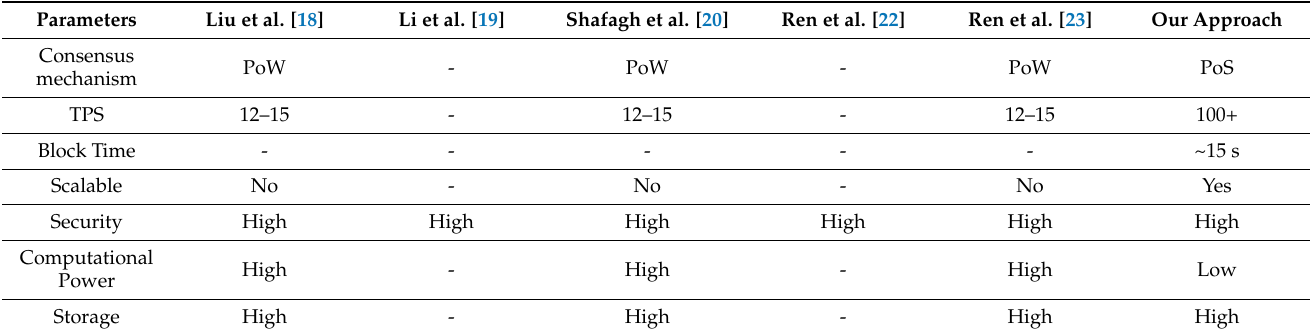
Table 1. Performance evaluation of the proposed